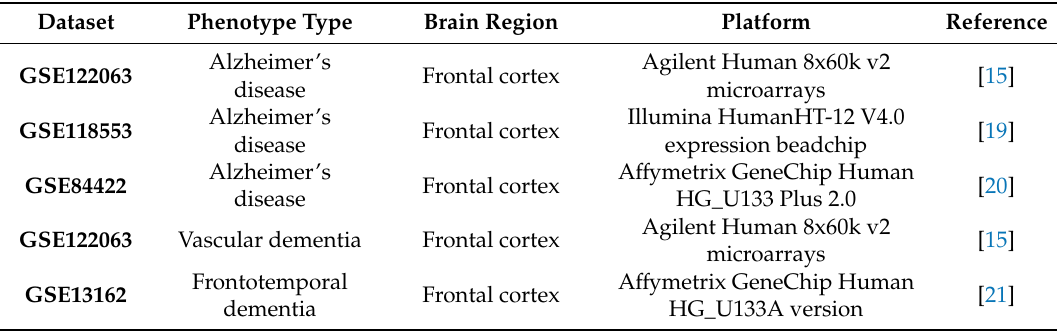
Table 1. Gene expression datasets selected in this